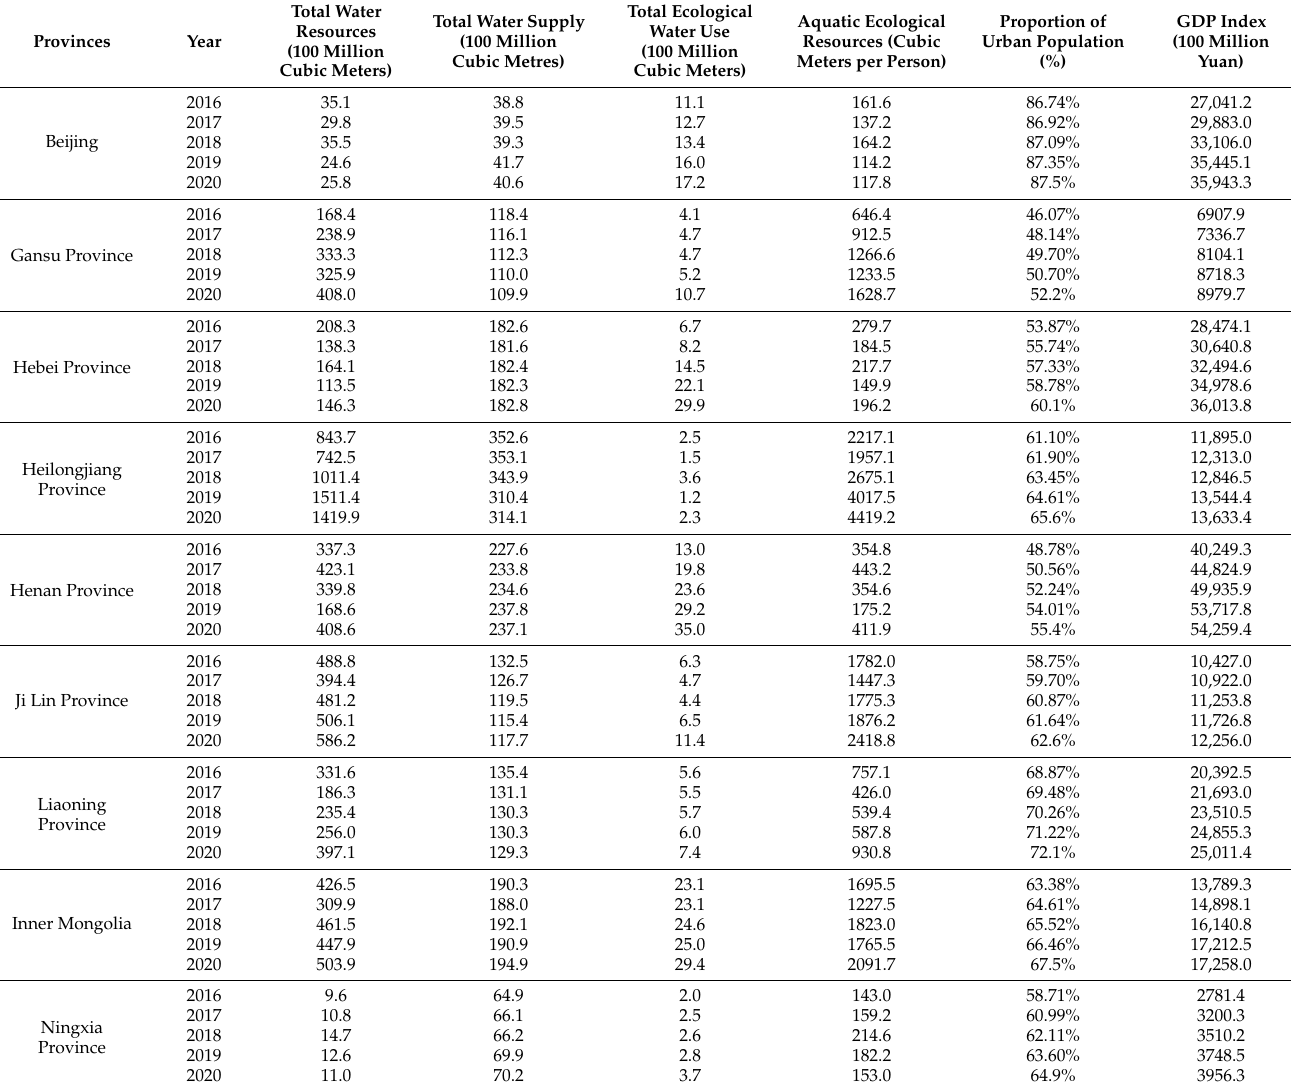
Table 1. Data from 15 provinces and cities in Northern China between 2016 and